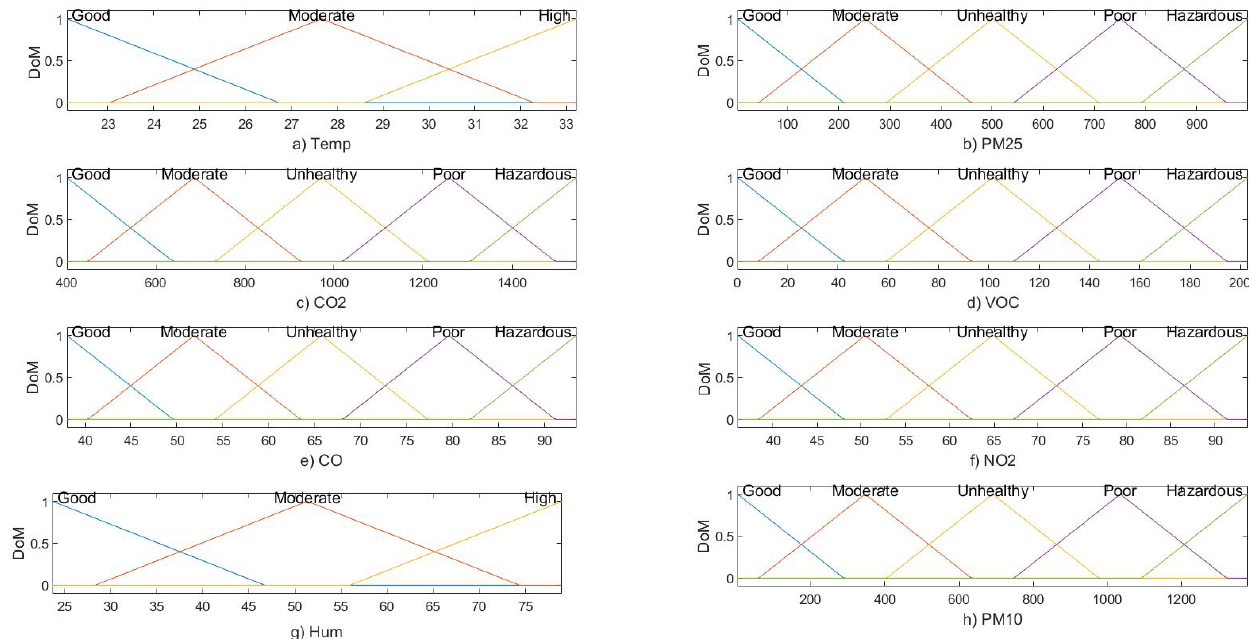
Figure 4. Membership functions for air quality parameters: ( a ) Temp, ( b ) PM 2.5 , ( c ) CO 2 , ( d ) tVOC, ( e ) CO, ( f ) NO 2 , ( g ) Hum and ( h ) PM 10